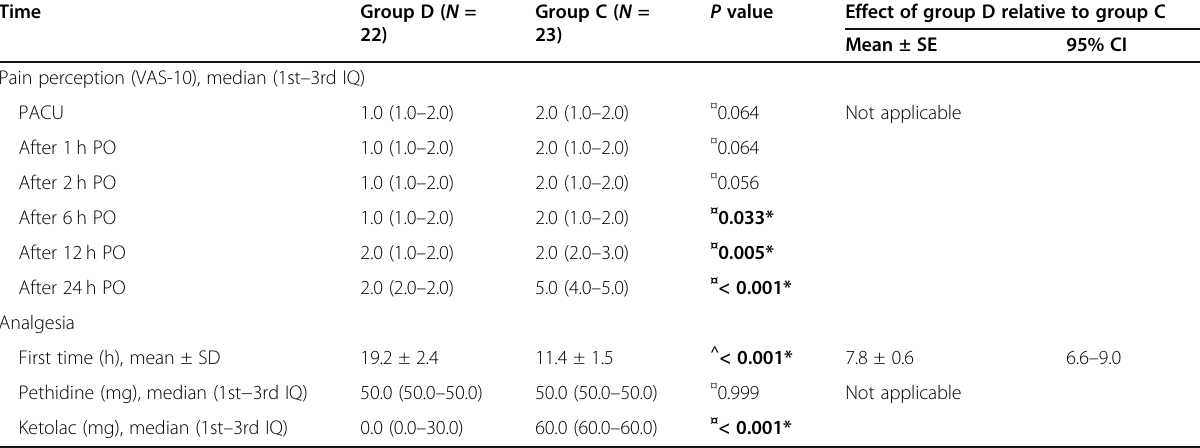
Table 3 Comparison between group C and group D according to VAS score and analgesia